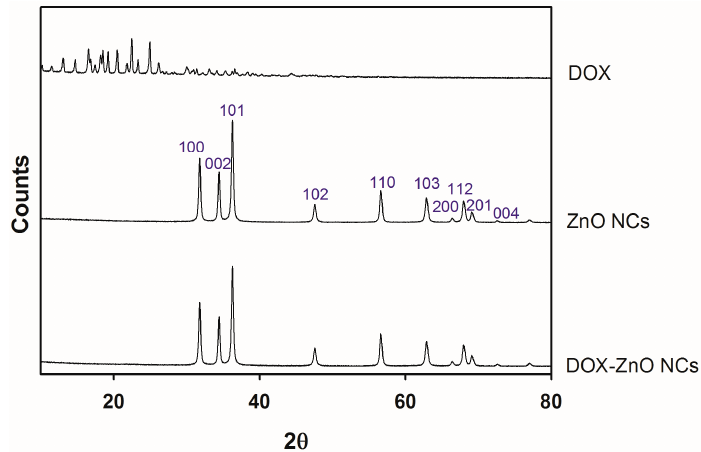
Figure 4. XRD profiles of DOX, ZnO NCs, and DOX-ZnO NCs. Counts value according to 2 θ of each sample is